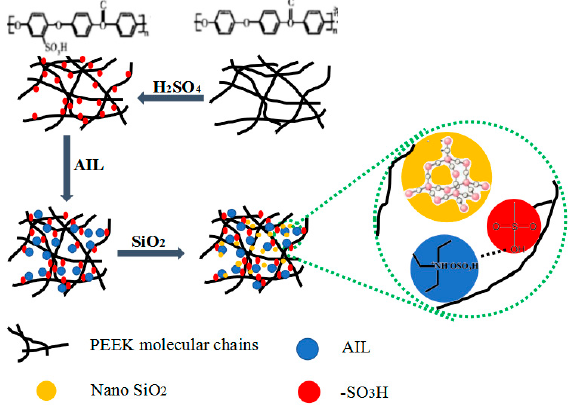
Figure 1. Schematic representation of the ternary composite membrane preparation process.